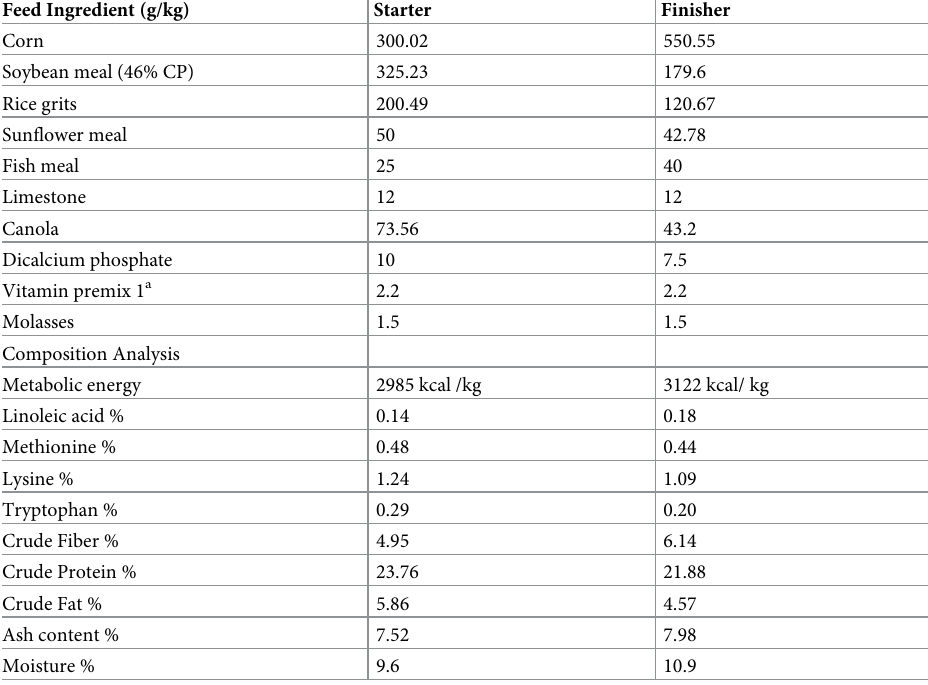
Table 1. Nutrient composition of diet fed to broilers and proximate analysis of feed ingredients. Feed Ingredient